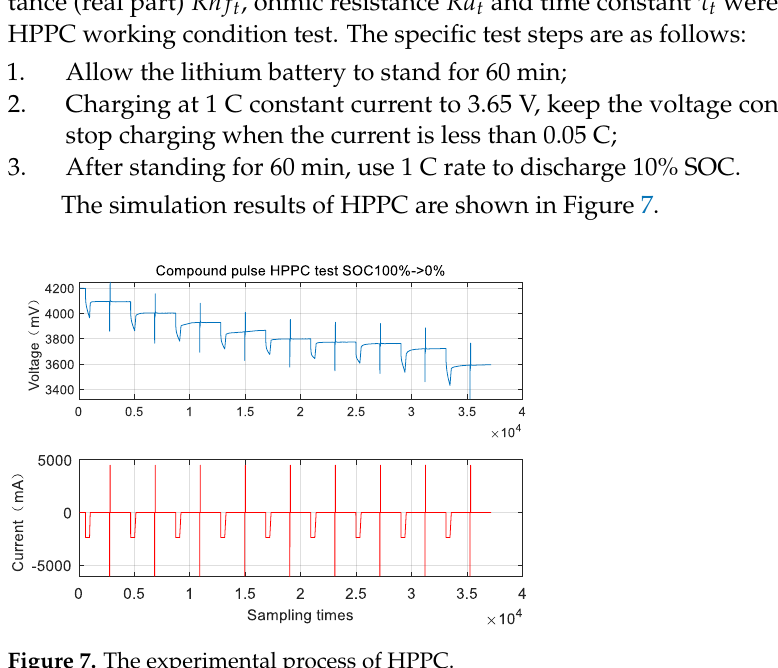
Figure 7. The experimental process of HPPC.